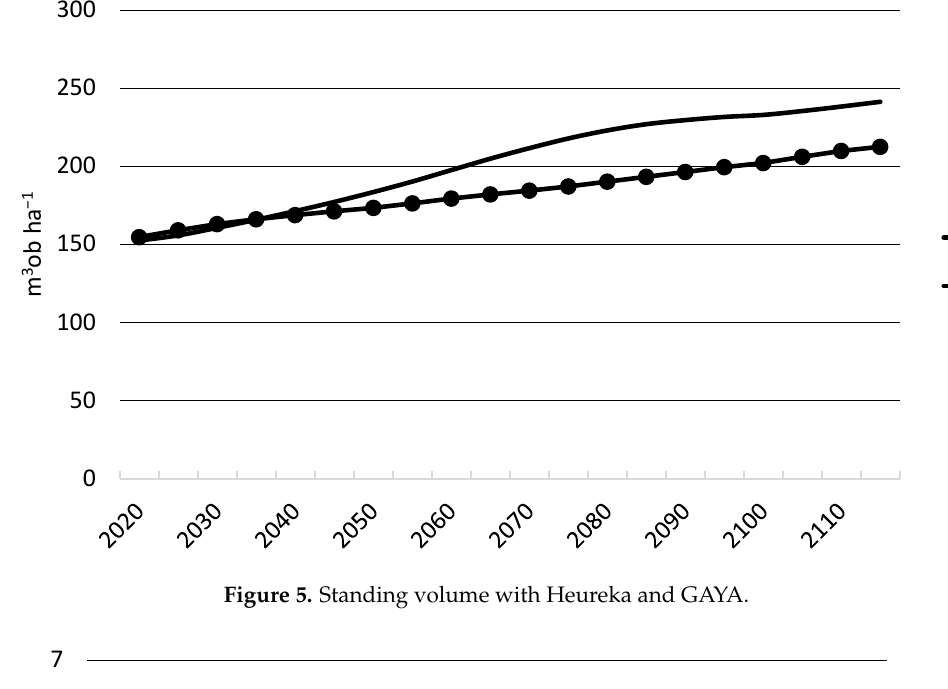
Figure 5. Standing volume with Heureka and GAYA.